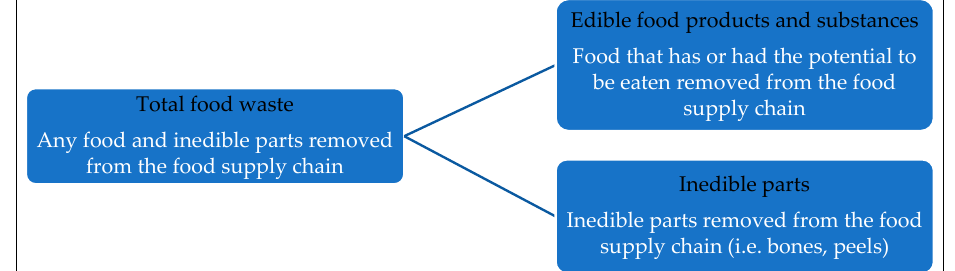
Figure 1. Division of food waste into edible and inedible food [11].